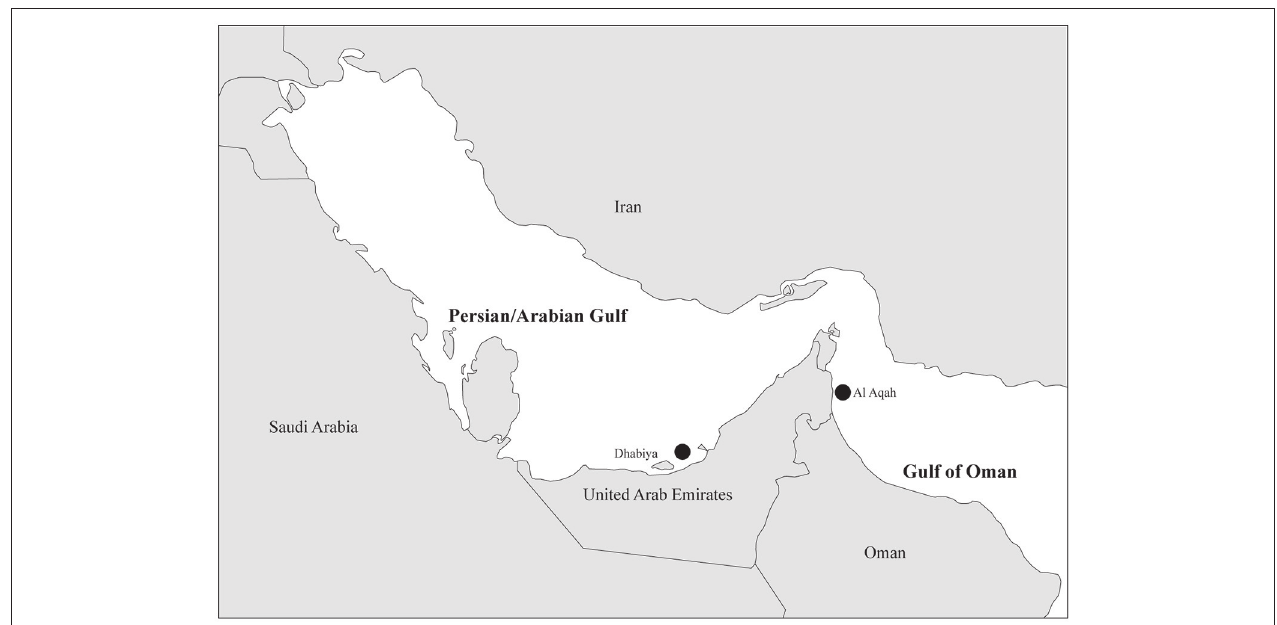
FIGURE 1 | Map of Arabian Peninsula indicating the location of the two sampling sites.